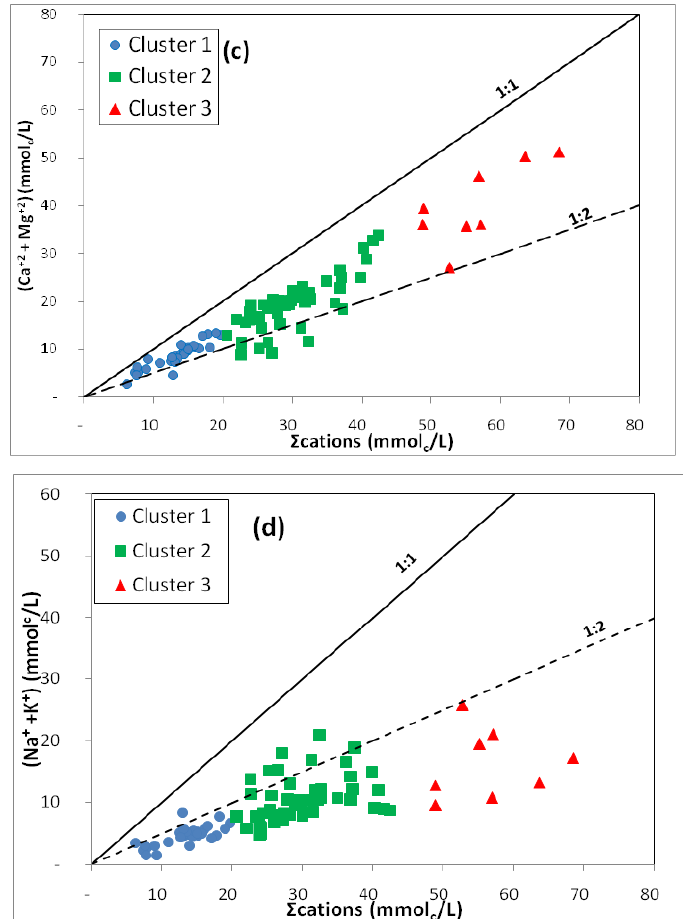
Figure 8. Bivariate plots of: ( a ) Na + /Cl − vs EC; ( b ) Na + vs Cl − ; ( c ) (Ca 2+ + Mg 2+ ) vs Σcations and ( d ) (Na + + Cl − ) vs Σcations.